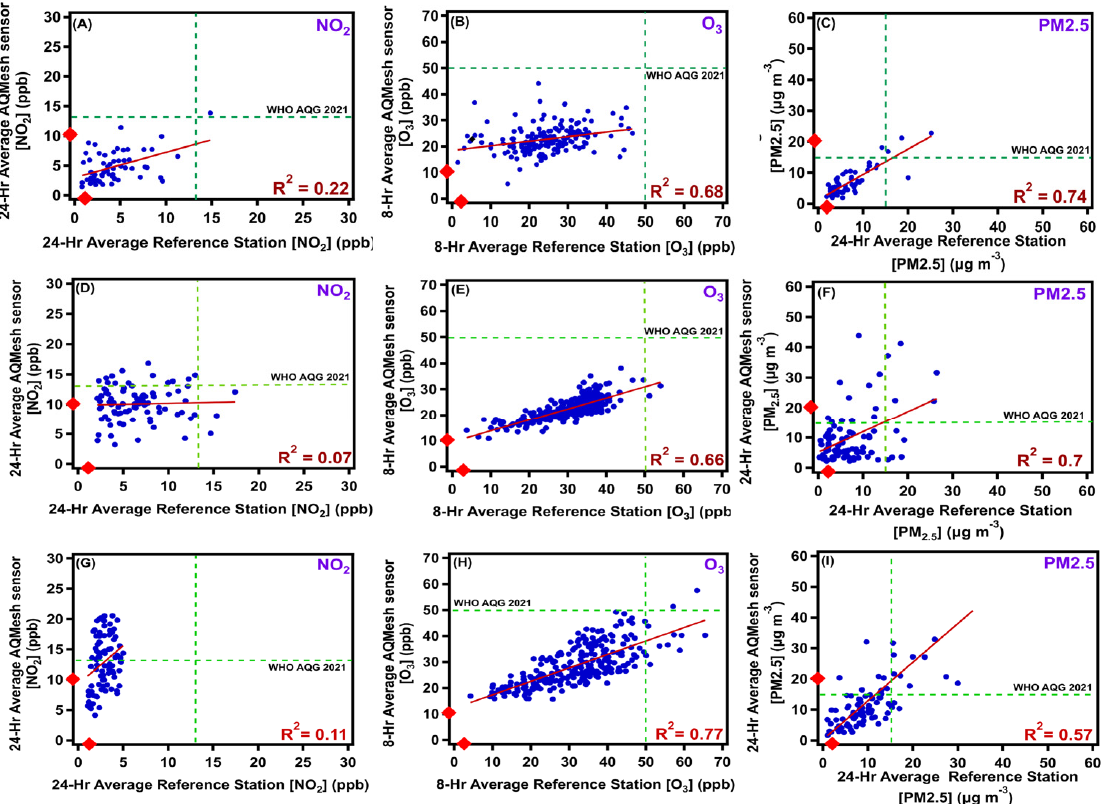
Figure 2. Regression plots of NO 2 , O 3 and PM2.5 comparing the co-located AQMesh pod (2450234, y-axis) with the MECP reference station (x-axis) for 22 September–22 November 2020 ( A – C ), 4 January–31 March 2021 ( D – F ), and 1 June–31 August 2021 ( G – I ). The WHO AQG (2021) are shown as dashed green lines in each regression plot. The solid red line is the regression line of best fit with R 2 values on the bottom right corner. The red diamond markers denote the LOC for each pollutant as shown in the Supplementary